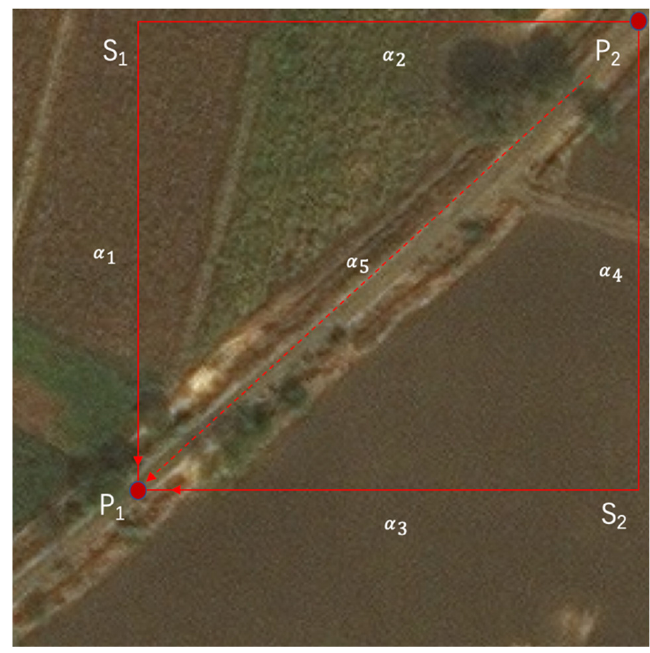
Figure 1. Recurrent dilemma.